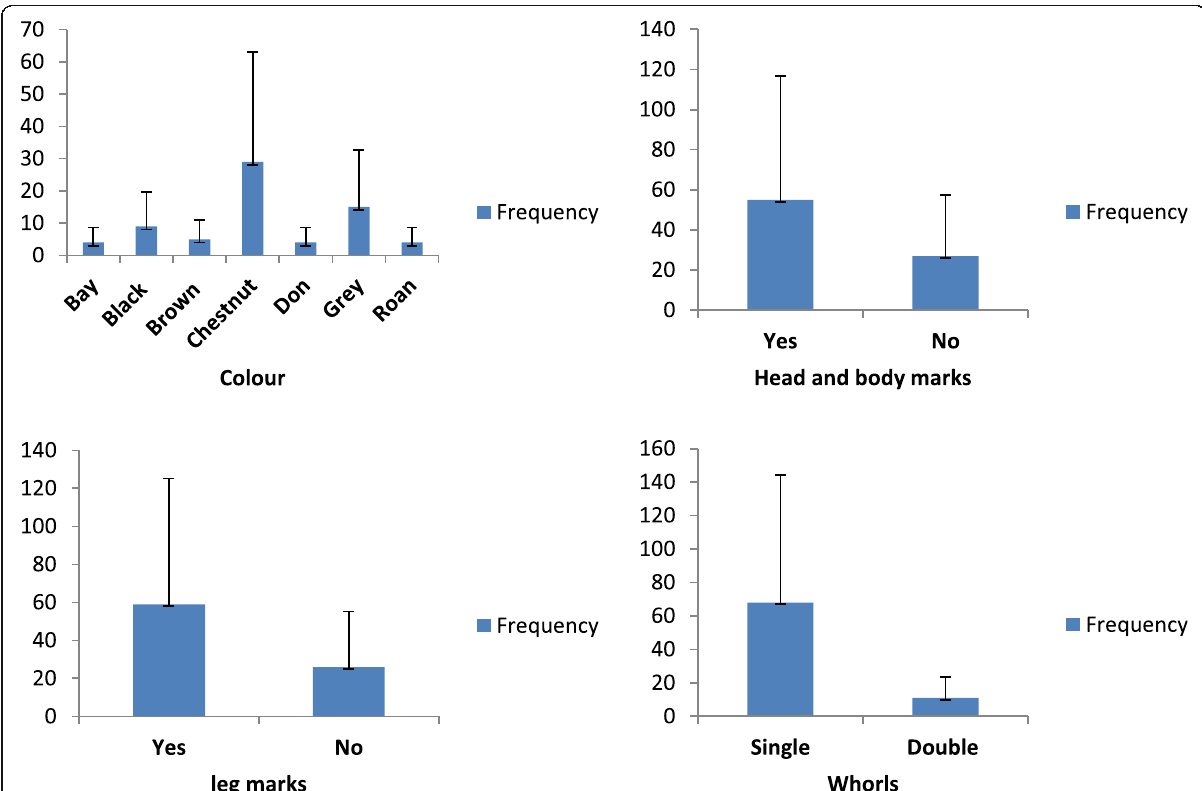
Fig. 2 Owners responses to part (B) questions. Results are represented as frequency of responses; error bars represent their